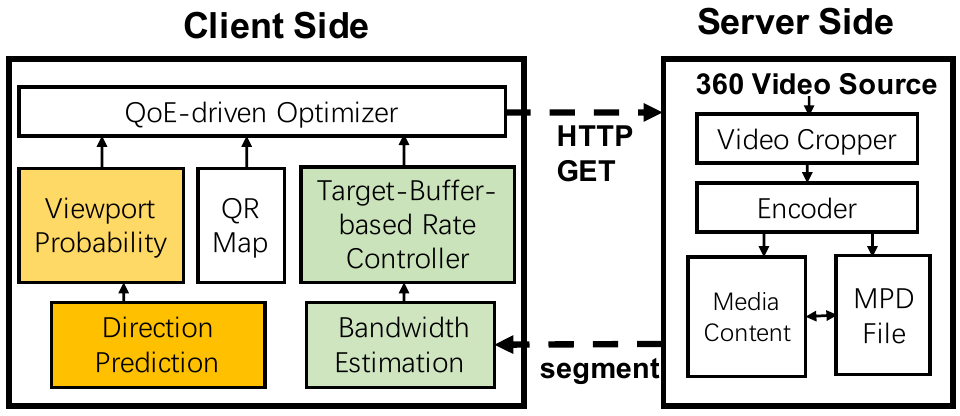
Figure 2. System